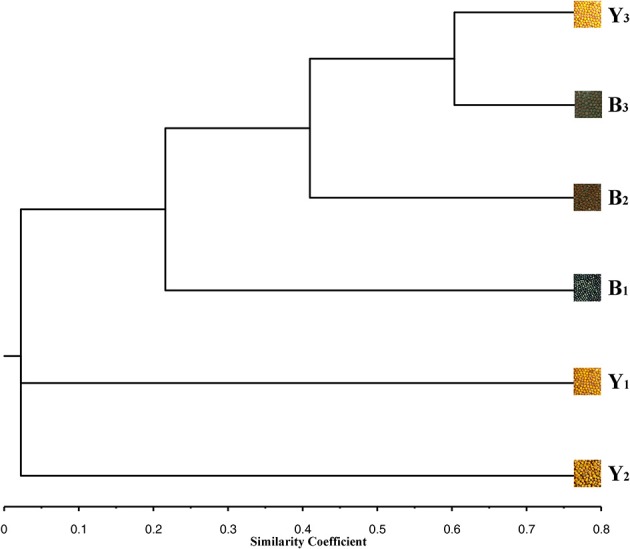
Phenogram showing Jaccard's genetic similarity coefficients for 6 inbred lines revealed by UPGMA clustering based on genetic fingerprints calculated from 2300 SNP markers. The phenotypic characteristics of 6 inbred lines were represented by seeds.